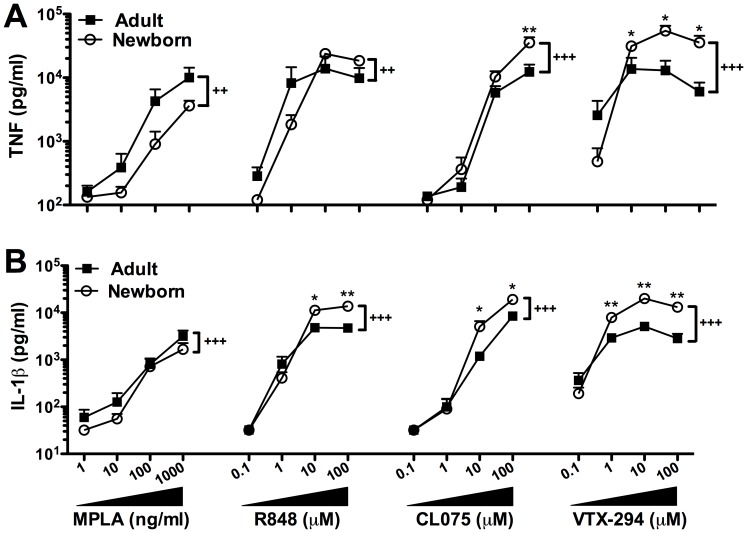
VTX 294 induces greater cytokine responses in newborn cord than adult peripheral blood.Human neonatal and adult blood was cultured for 6 h with MPLA (1, 10, 100, 1000 ng/ml), CL075, R848 and VTX-294 (all 0.1, 1, 10, 100 µM) and supernatants collected for TNF or IL-1β ELISA. Mean ± SEM of agonist-induced cytokine production are shown for n = 5–6. For comparisons between overall groups (newborn vs. adult), Kruskal-Wallis test with Dunn’s post test were applied, with significance denoted as ++p<0.01, +++p<0.001. For analyses at individual doses (newborn vs. adult), unpaired Mann-Whitney test was applied at each concentration and statistical significances are denoted as follows: *p<0.05 and **p<0.01.